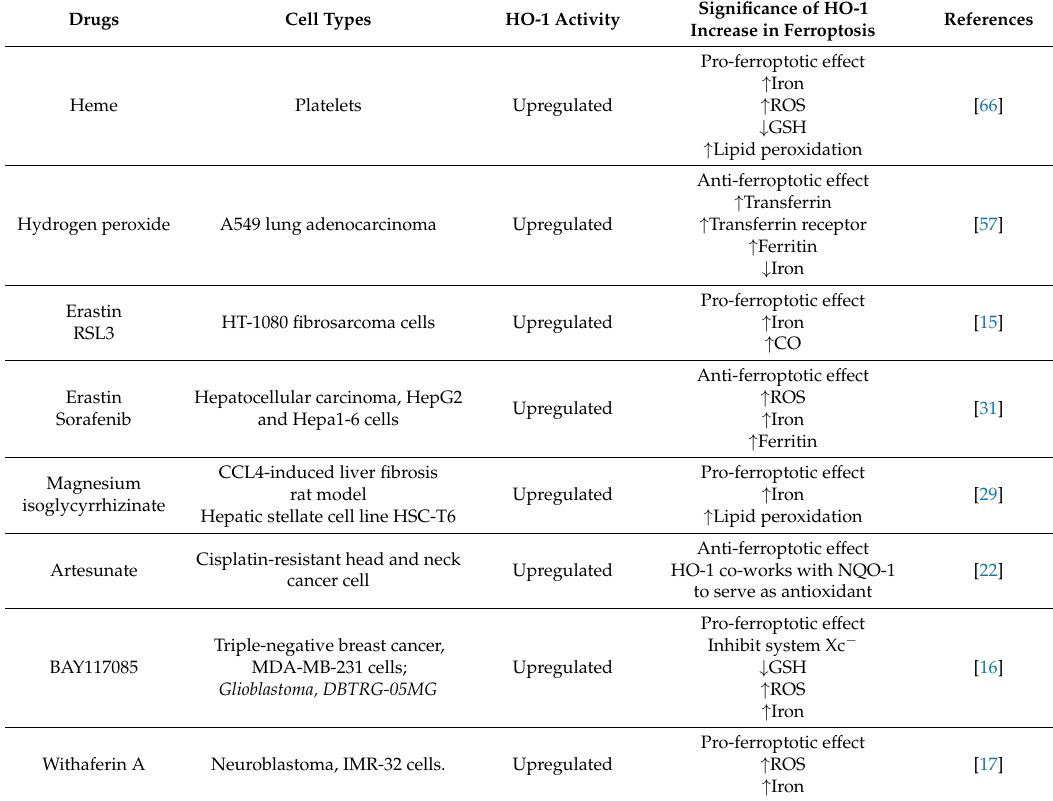
Table 1. Role of increased HO-1 in the ferroptosis and anti-ferroptosis response to different